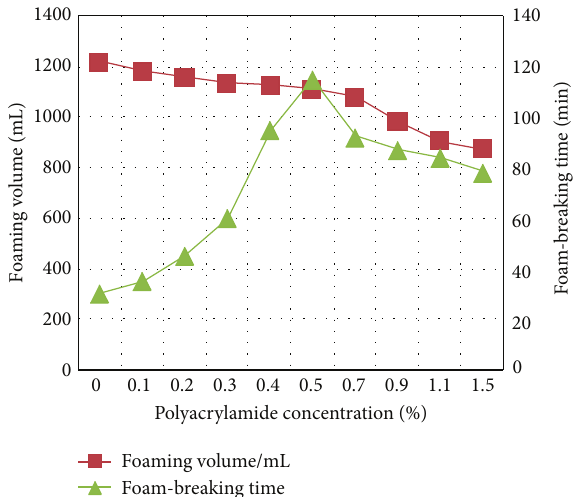
Figure 6: The influence of polyacrylamide on foaming volume and antifoam time.